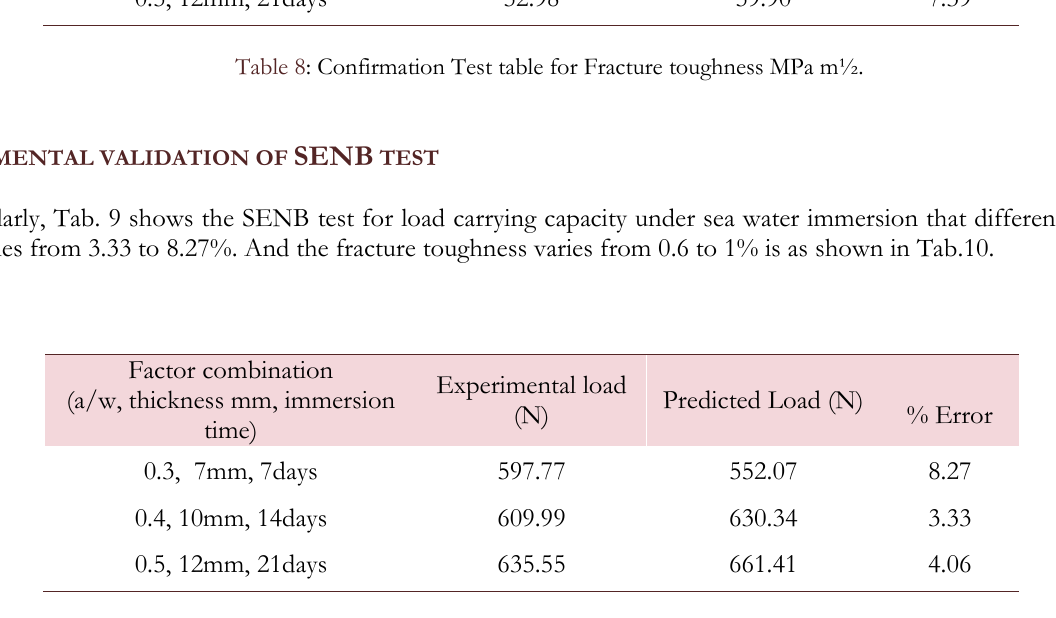
Table 9: Confirmation Test table for Load carrying capacity (N).